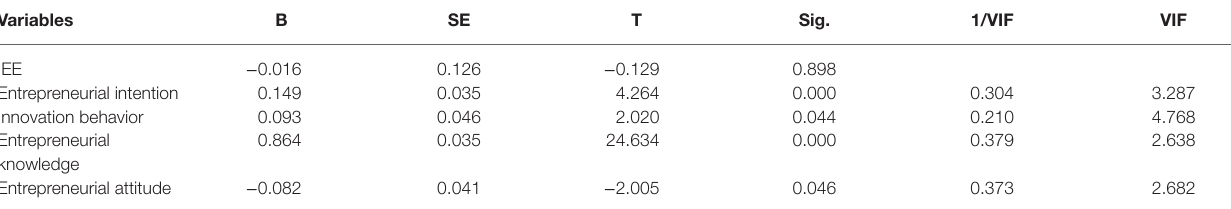
TABLE 6 | Correlation